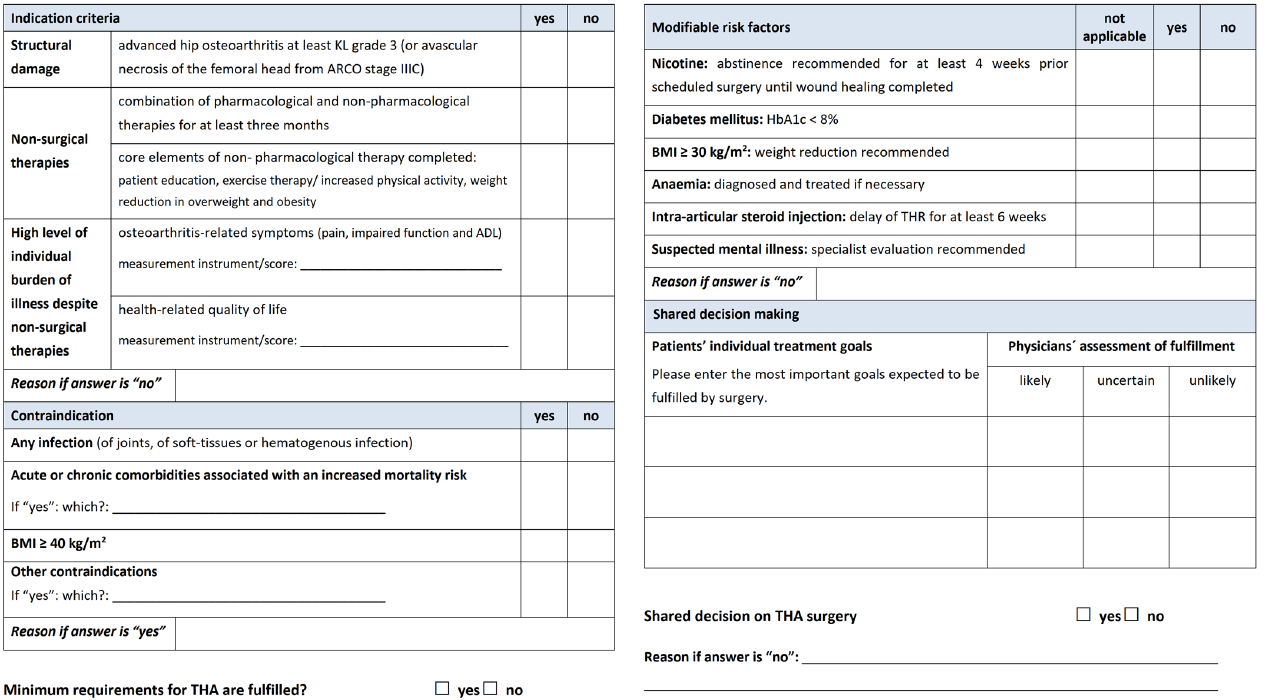
Figure 3. EKIT-Checklist of indication and contraindication criteria for decision making on THA.